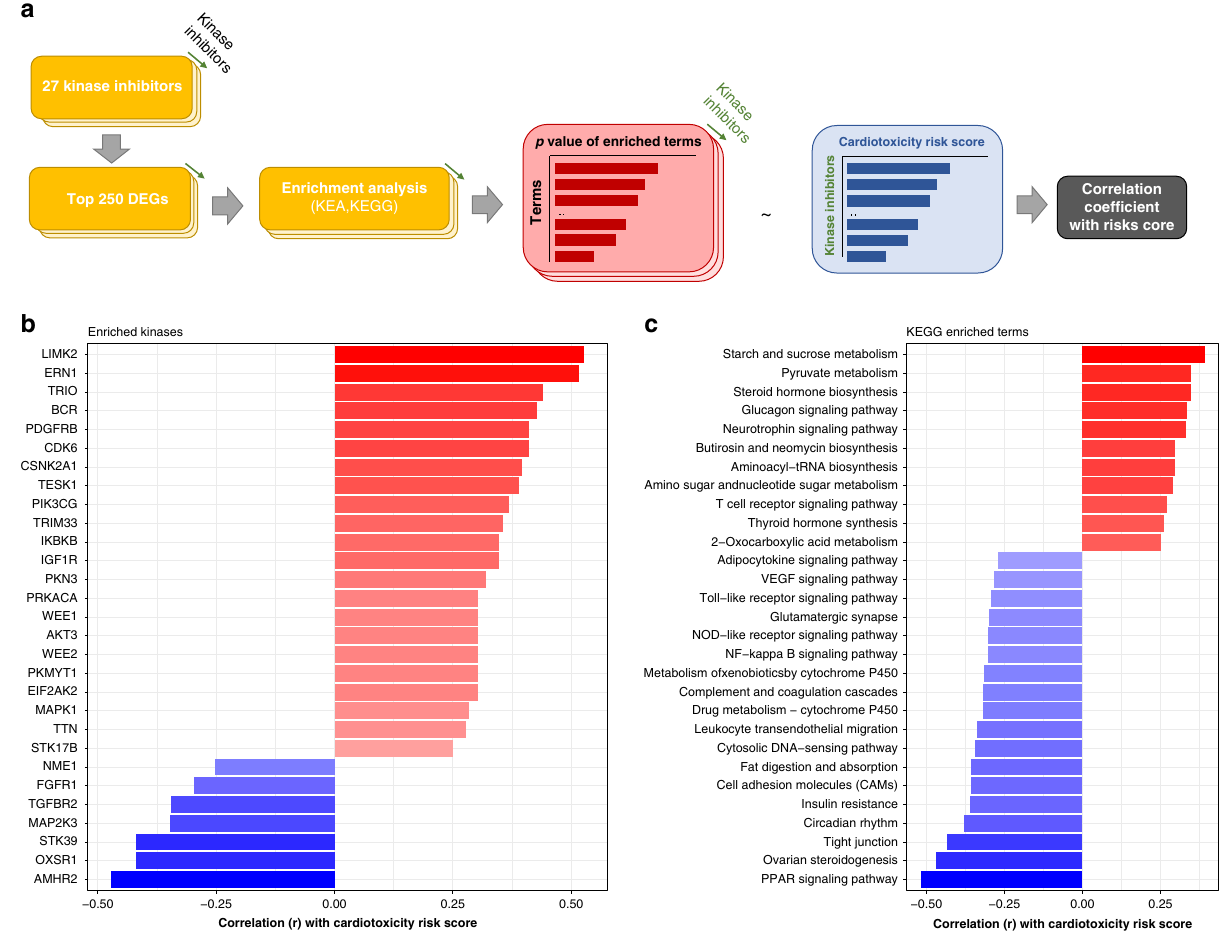
Fig. 3 Analysis of transcriptomic pro fi ling data in relation to cardiotoxicity risk. a Flowchart indicating ranked lists of top 250 differentially expressed genes ranked by p value for each kinase inhibitor across cell lines from the transcriptomic cardiomyocyte pro fi ling, which were then enriched and subsequently related to clinical cardiotoxicity risk scores. Enriched kinases ( b ) and enriched KEGG pathways ( c ) ( p < 0.05) that show a correlation coef fi cient > |0.25| with cardiotoxicity risk scores and the associated enrichment p values. Source data are provided in source data fi